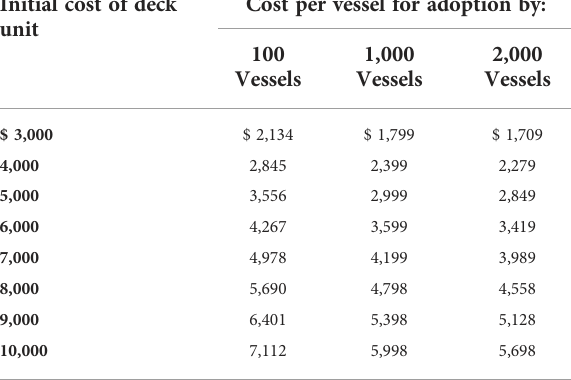
TABLE 3 Example of cumulative average cost for on-demand fi shing deck units, per vessel, with a 95% learning rate. Initial cost of